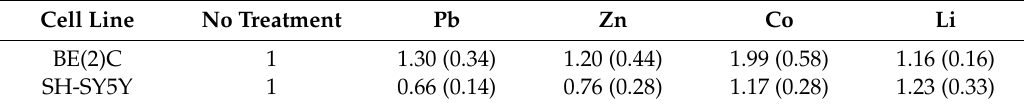
Table 4. Relative MT3 mRNA levels after metal treatment. All results are normalized to non-metal treated control cells and the housekeeping gene HSP90ABI . Results are the average of 6 and 5 biological replicates, for BE(2)C and SH-SY5Y cells, respectively. Each biological replicate is the average of 3 technical replicates. Standard errors are presented in